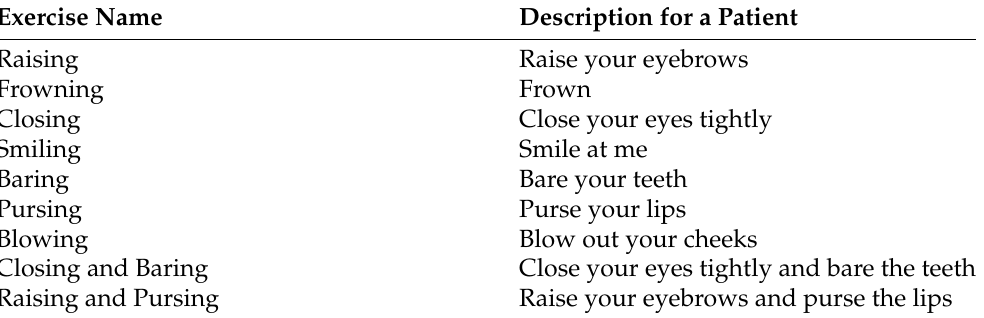
Figure 2. Facial measurement exercise scheme: from surgery to data collecting. Table 3. Table of measured